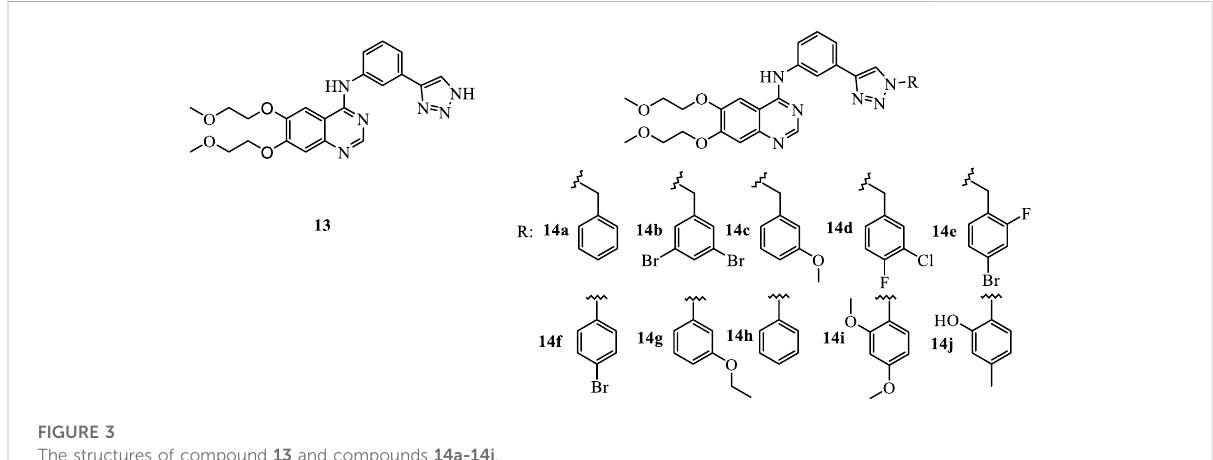
FIGURE 3 The structures of compound 13 and compounds 14a-14j